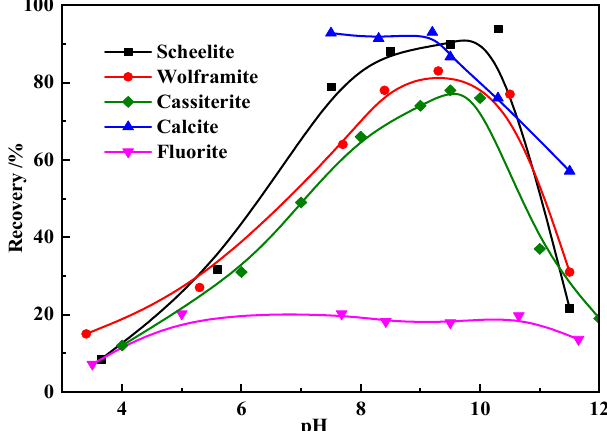
Figure 2. The floatability of scheelite, wolframite, cassiterite, fluorite, and calcite minerals with Pb–BHA complexes as the collector (C BHA = 1.5 × 10 −4 mol/L, C Pb = 2.5 × 10 −4 mol/L, C terpineol = 12.5 μL/L).